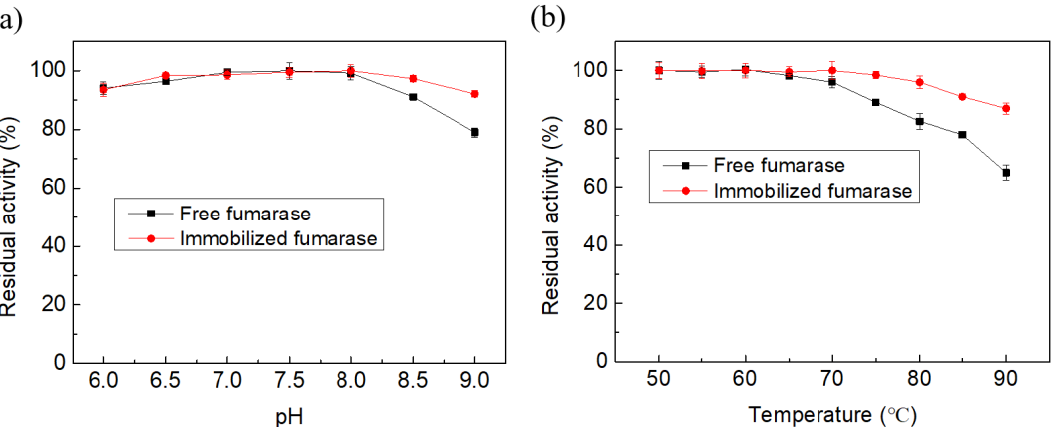
Figure 3. The residual activity of immobilized and free fumarase incubated at different pH ( a ) and temperature ( b ) conditions for 2 h.